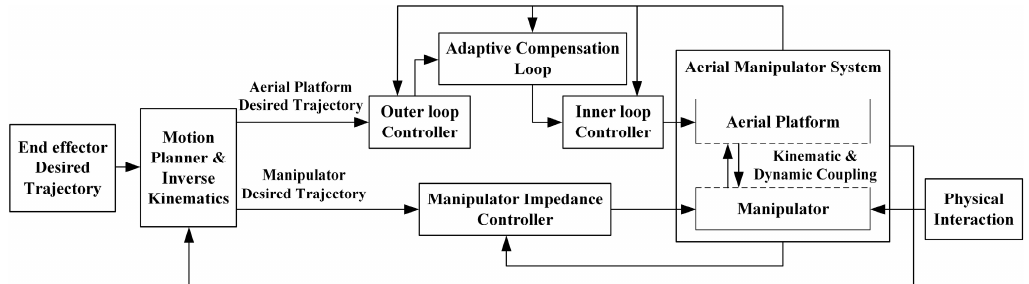
Figure 3. The configuration of the composite controller.